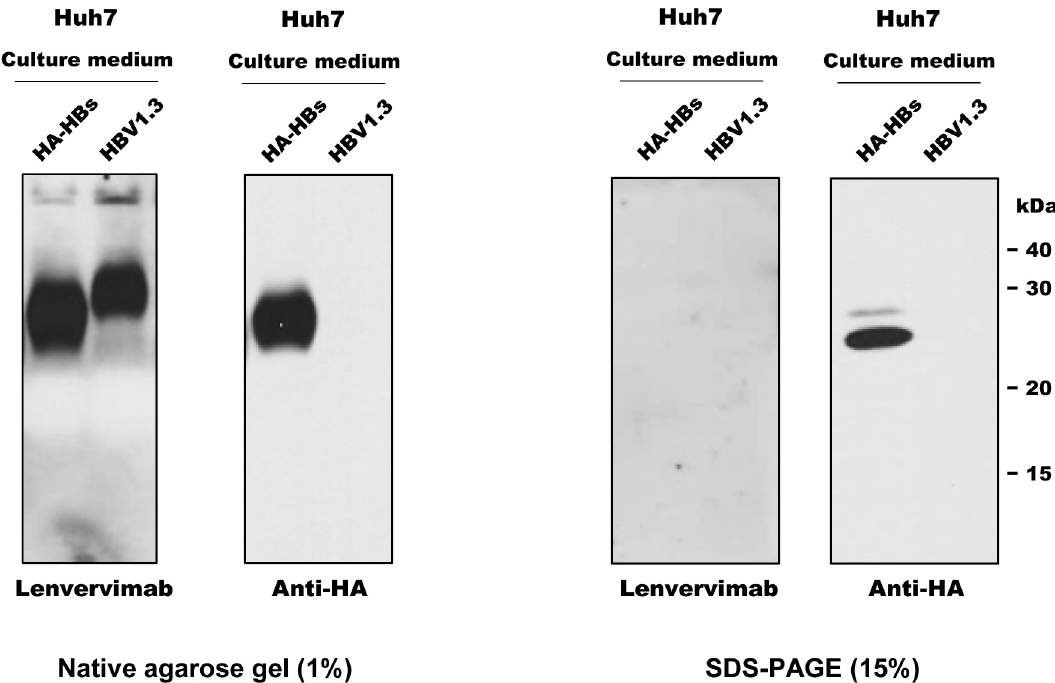
Fig 2. Lenvervimab binds HBsAg only in nondenaturing conditions. Aliquots of culture media from Huh7 cells transfected with pHM6-HA-HBs or HBV1.3 were separated on a 1% agarose gel in nondenaturing condition (Two panels shown on the left) or a 15% polyacrylamide gel in denaturing condition (shown on the right). Protein samples transferred to PVDF membrane were probed with Lenvervimab or anti-HA antibody, respectively.